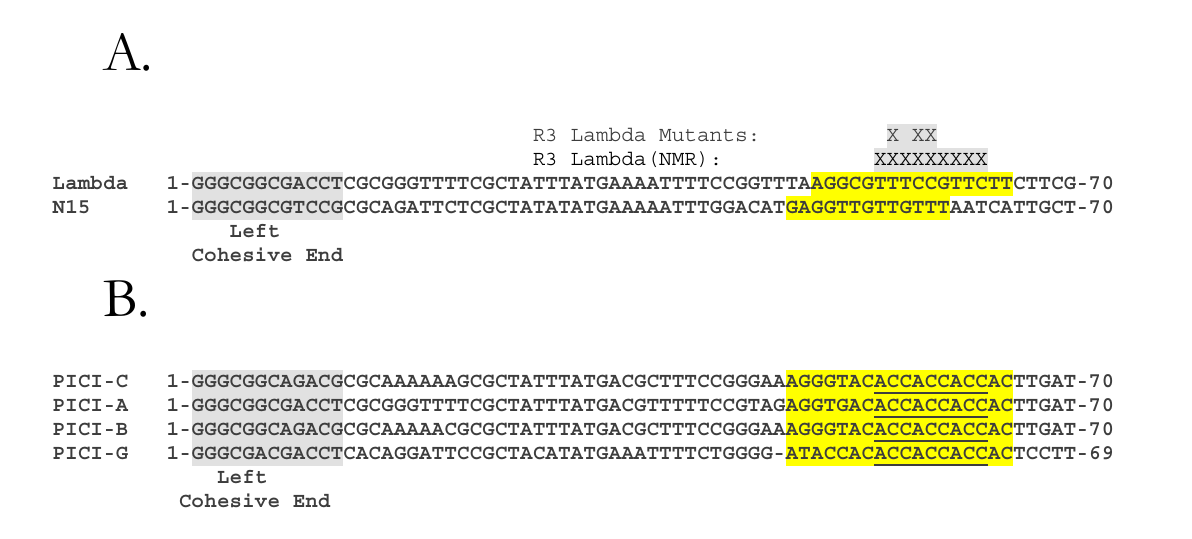
Figure 2. cos Alignments and R3 sites. ( A ) Alignment of the left ends of λ and N15 DNAs. Sequences start at bp 1, the first base of the left cohesive end. The 12 bp left cohesive end sequence is grey- highlighted. The position of R3- λ , bp 50–65, based on sequence identity with R2 and R1, is highlighted in yellow. Additionally shown is the protein-interactive segment bp 55–63, as determined by NMR. Three R3- λ bp, 56, 58, and 59, have functional roles in DNA packaging as defined by genetic and biochemical studies. The location of R3-N15, defined by linker scanning mutagenesis, bp 48–60, is highlighted in yellow. ( B ). The proposed R3 segments, bp 48–65 for PICI-A, PICI-B, PICI-C, and bp 47–64 for PICI-G, are highlighted in yellow. The left cohesive ends are highlighted in grey, and the bp 55–63 segments of the cos -PICIs are underlined.